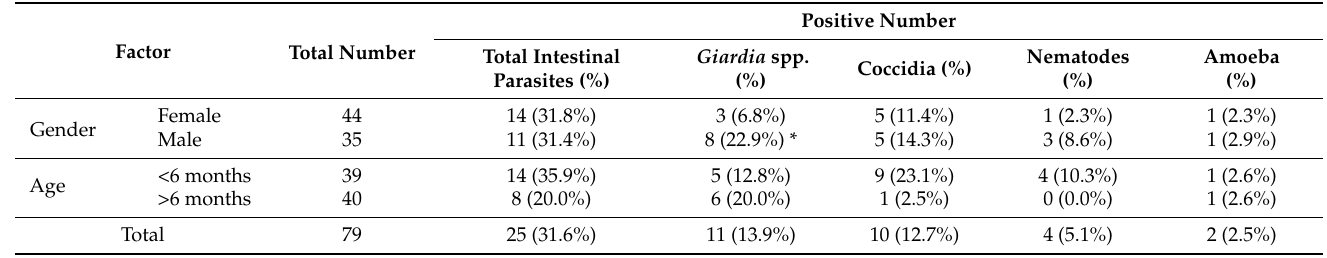
Table 2. Giardia and other intestinal parasites infections in pet prairie dogs based on microscopic examination.